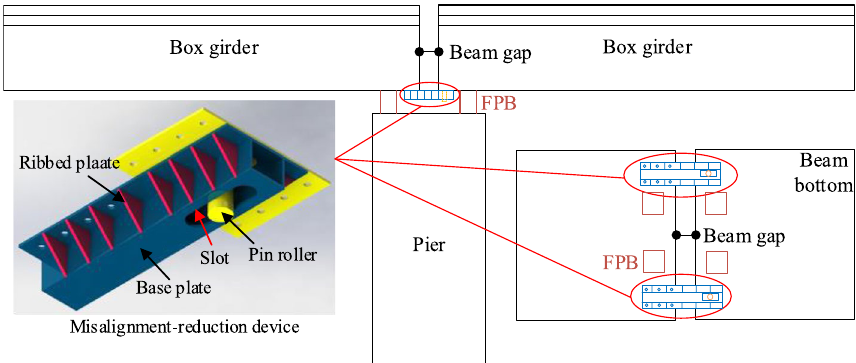
Fig. 14 Proposed misalignment control